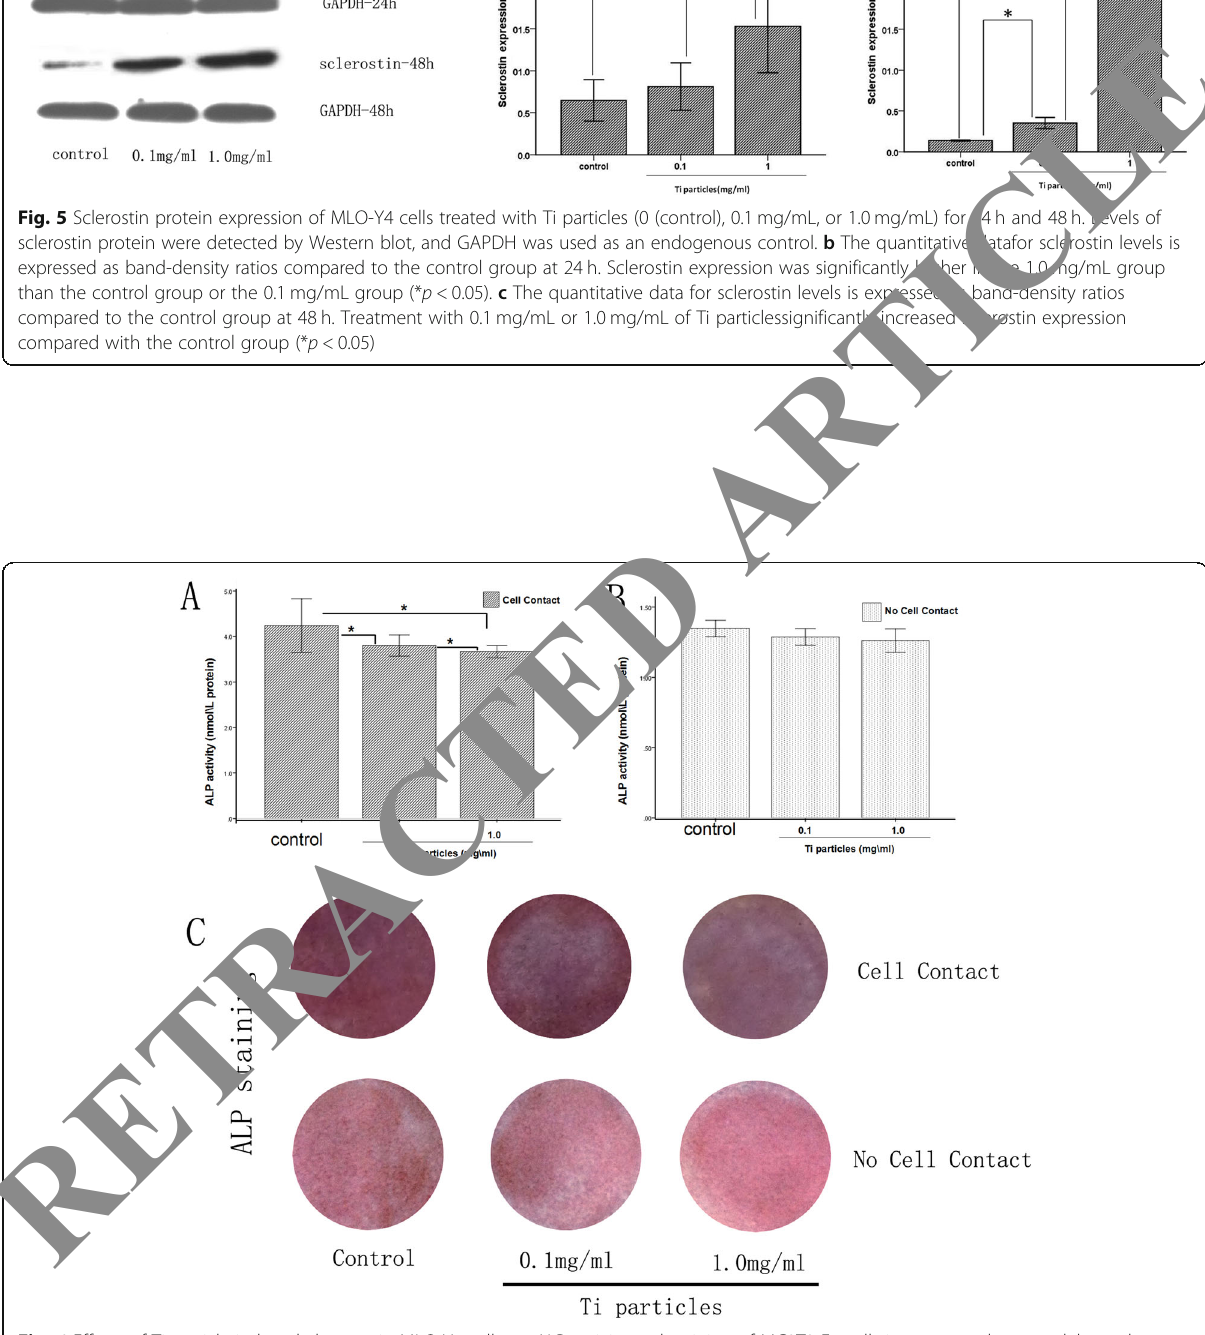
Fig. 6 Effects of Ti particle-induced changes in MLO-Y4 cells on ALP activity and staining of MC3T3-E1 cells in two co-culture models on day 7. Data showing ALP activity are expressed as mean ± S.D. a In the “ Cell Contact ” model, ALP activity of MC3T3-E1 cells significantly decreased as the concentration of Ti particles increased (* p < 0.05, ** p < 0.01). b In the “ No Cell Contact ” model, the ALP activity of MC3T3-E1 cells treated with 0.1 mg/mL and 1.0 mg/mL Ti particles did not differ significantly from the control. c ALP staining in the “ Cell Contact ” model showed fewer positive cells (cytosol red coloration) in the 0.1 mg/mL and 1.0 mg/mL groups compared with the control. In the “ No Cell Contact ” model, no significant differences in ALP staining were observed in any